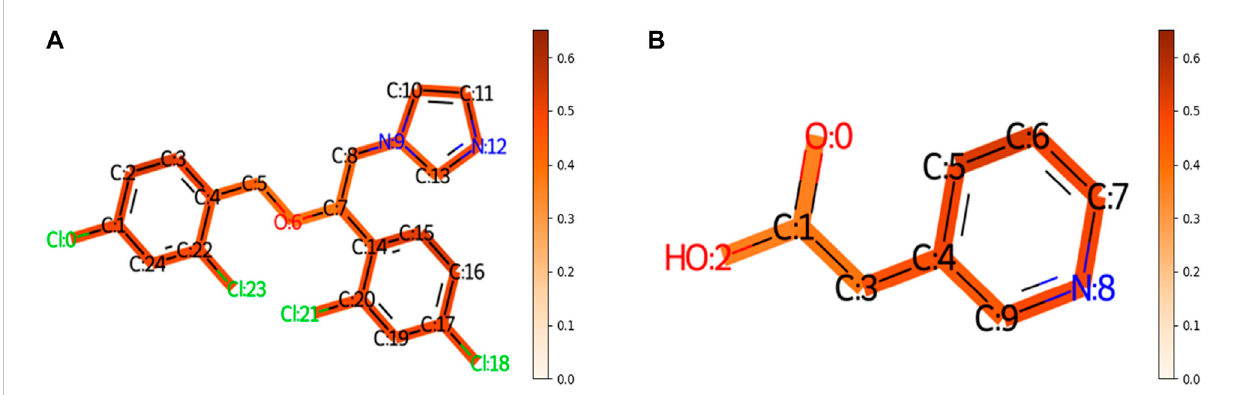
FIGURE 5 The importance of molecular structures during the prediction process of the GNN module of the multi-task FP-GNN model on the CYPs dataset. The darker the color, the more important are for the structures. (A) Represents an active molecule on the fi ve isoforms. (B) Represents an inactive molecule on the fi ve isoforms.